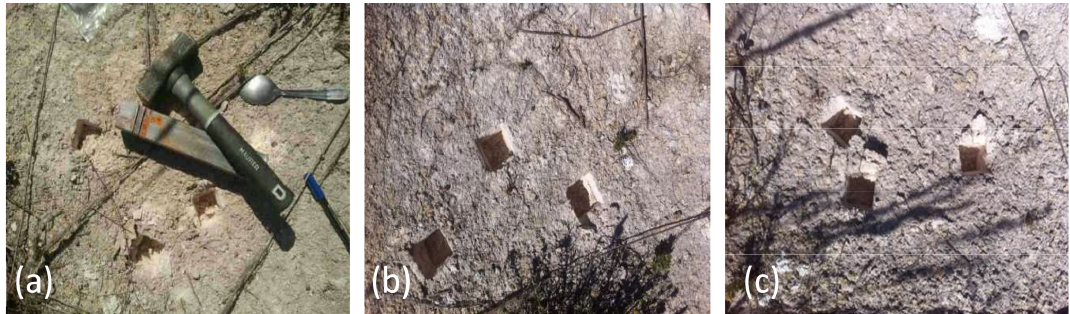
Figure 16. (a) Corer and hammer used to get the soil samples. (b, c) Examples of replicated samples collected in bare ground areas in the field (please note that only three cores are collected in the pictures shown here). Photographs by Victoria